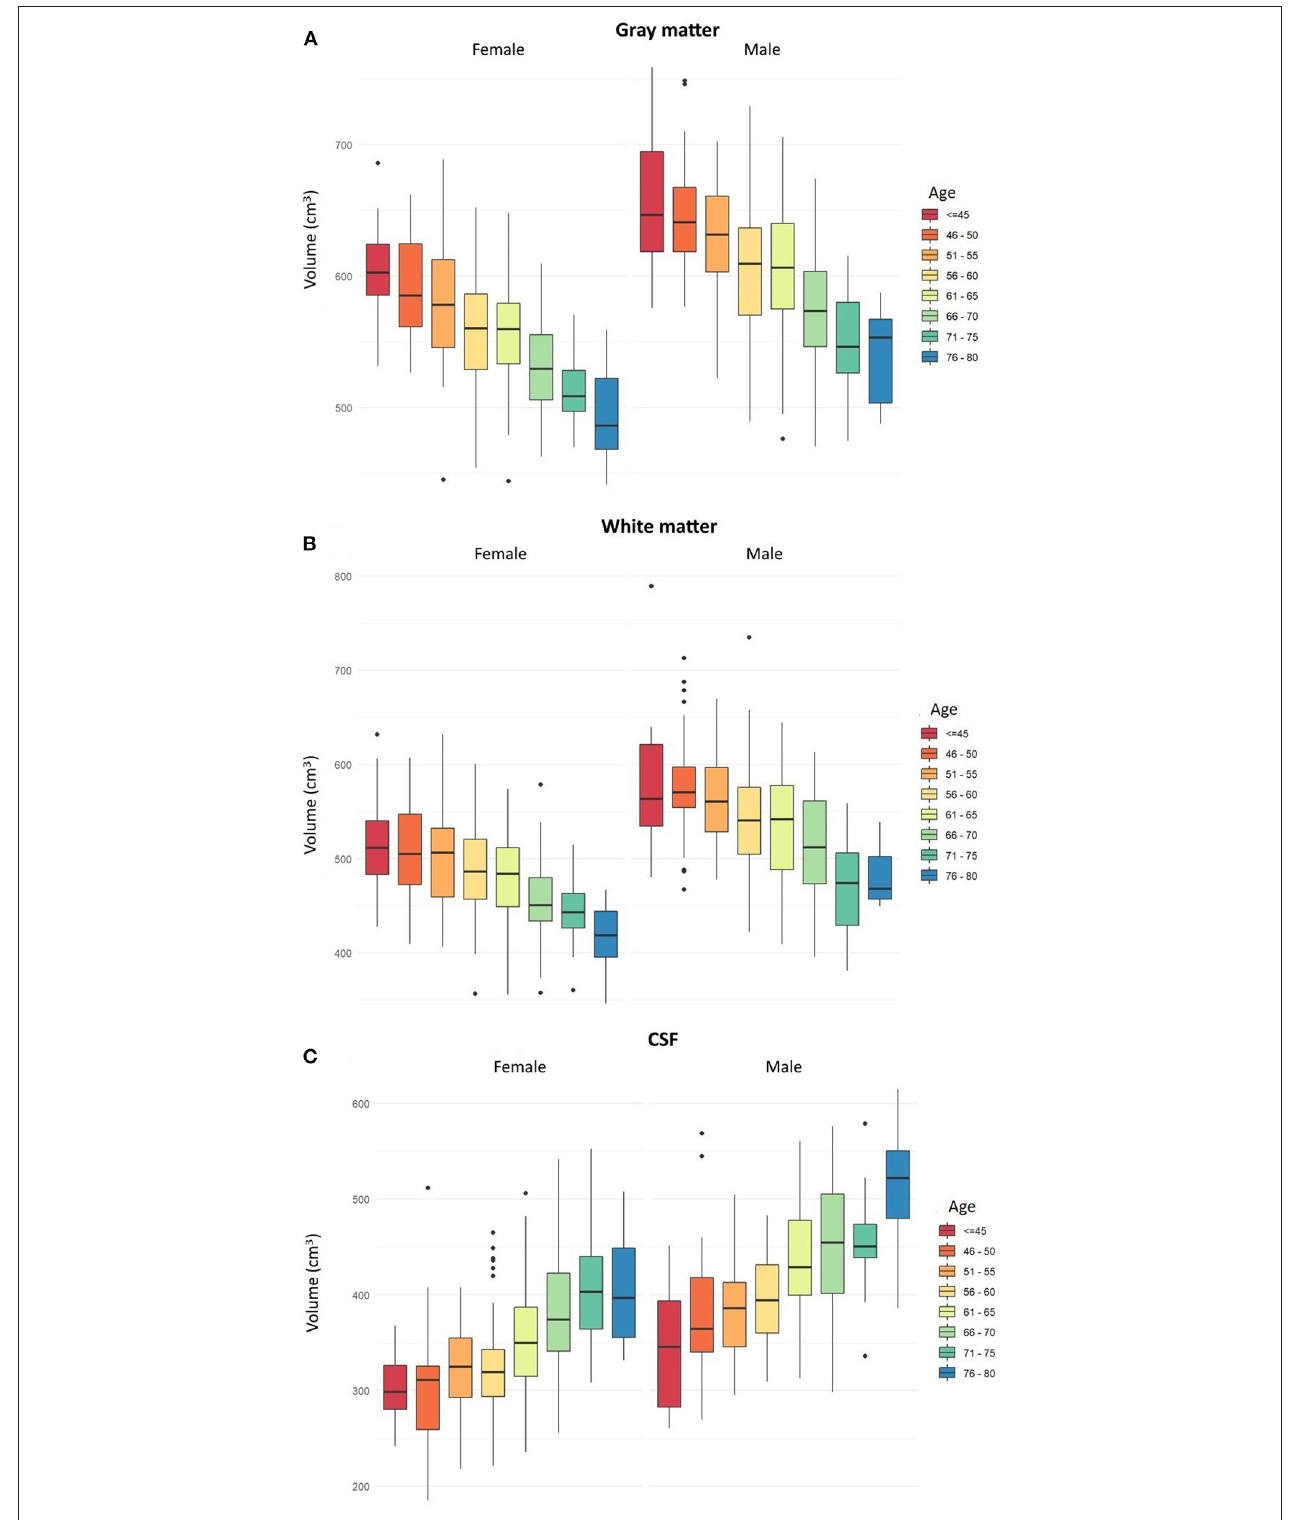
FIGURE 1 | Box plots showing age-related changes in the volumes of (A) total gray matter, (B) total white matter, and (C) cerebrospinal fluid separately in men and women. Error bars show the standard error of the mean values. Dots represent single subjects with outlier values. The box plots a, b and c are based on parametric information and statistical analyses from Tables 1 – 3 ,